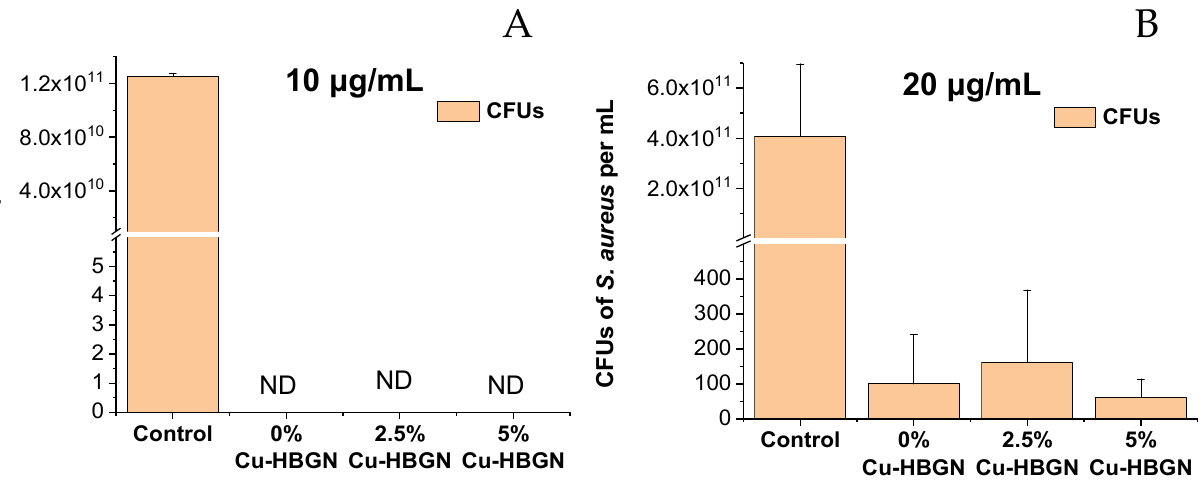
Figure 8. Results obtained from the bacterial growth inhibition test in the planktonic state using ( A ) 10 µg/mL of HBGN against E. coli and ( B ) 20 µg/mL of HBGN against S. aureus . Non-detected CFUs are marked as ND.